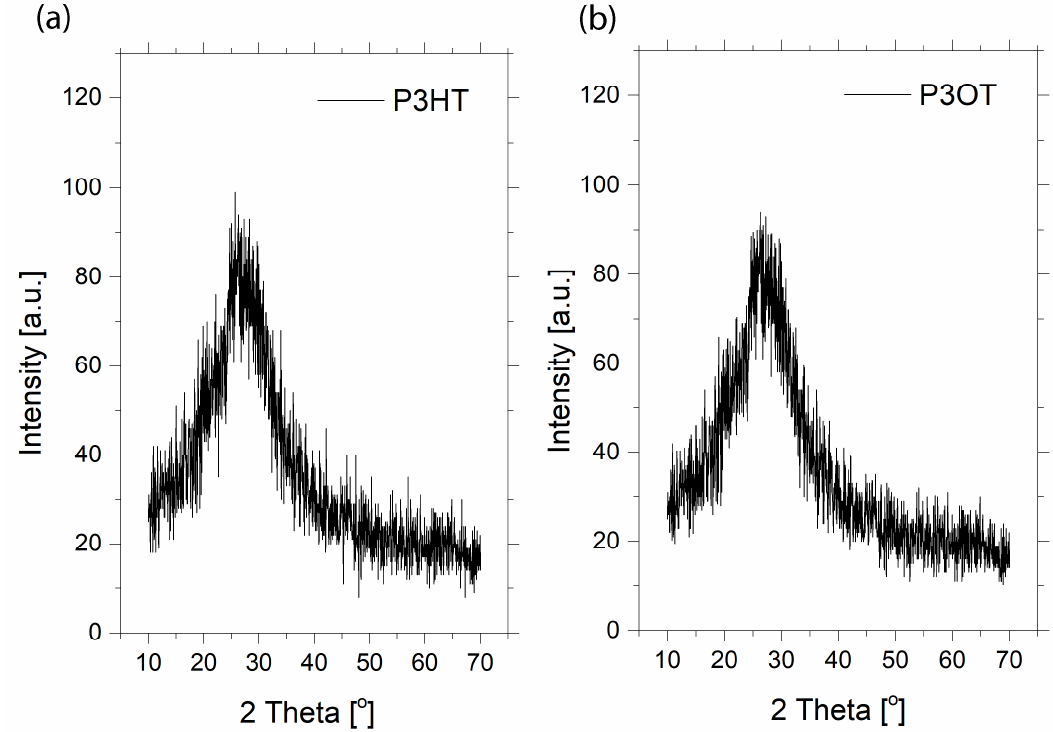
Figure 3. XRD diffraction patterns of the P3HT and P3OT polymers films deposited by a spin-coating method, ( a ) P3HT; ( b ) P3OT.